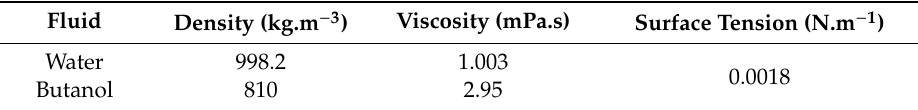
Table 1. Physical properties of two